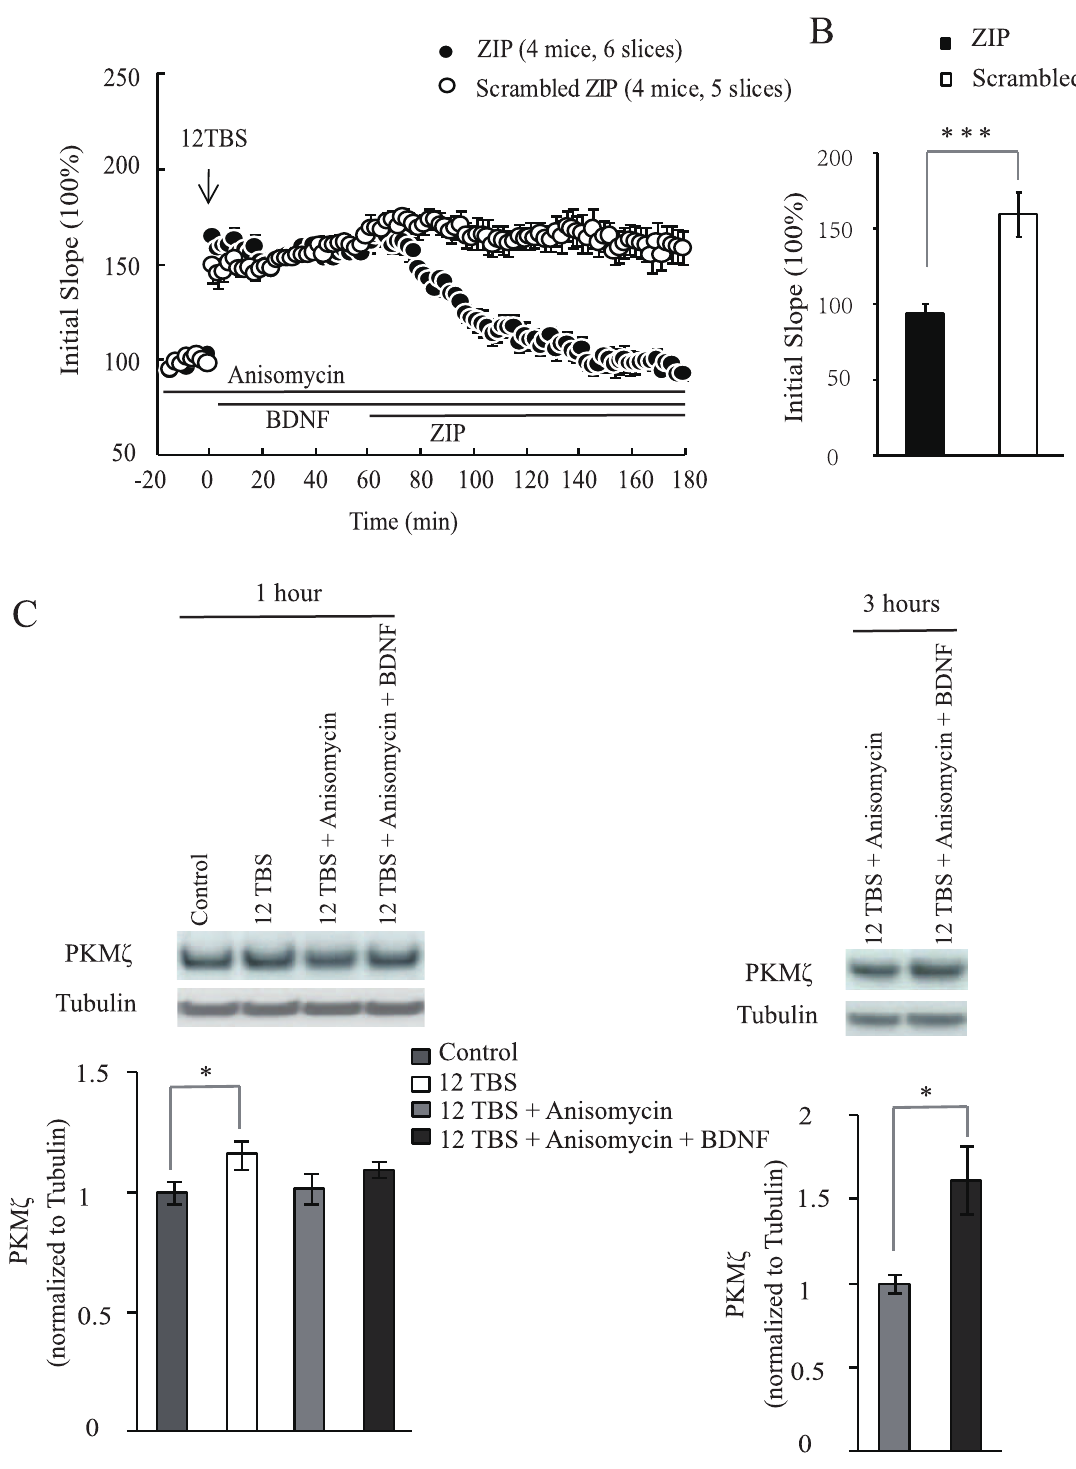
Figure 3. BDNF modulates activity-dependent PKM f level to sustain L-LTP in the absence of protein synthesis. (A, B) Rescuing L-LTP impairment by BDNF in the presence of anisomycin is PKM f -dependent. (A) Applications of various drugs were indicated by horizontal bars. Anisomycin (40 m M) was used throughout the entire experiment. BDNF (200 ng/ml) was applied 3 minutes after 12TBS stimulation and successfully rescued L-LTP impairment. ZIP was applied at 1 hour after stimulation and completely abolished L-LTP. (B) Quantification of the initial slope from the last 5 minutes of recording. (C) PKM f protein level of hippocampal CA1 derived from WT mice at 1 hour and 3 hours after 12TBS stimulation. Tubulin was used as loading control. The 12 TBS group was normalized against control group. The 12 TBS plus BDNF and anisomycin treatment groups were normalized against that without BDNF treatment. Representative blots are shown on top of the quantification of data (3–5 slices per treatment, n=3 independent experiments). doi:10.1371/journal.pone.0021568.g003 PLoS ONE |